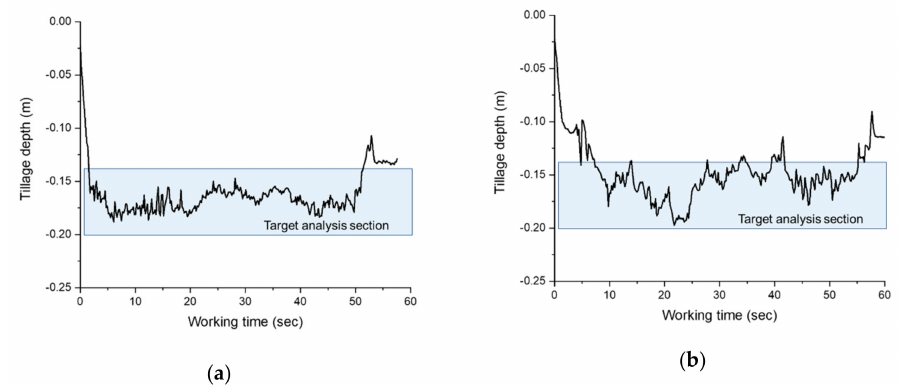
Figure 8. Measured tillage depth during plow tillage at ( a ) M3–low; and ( b )